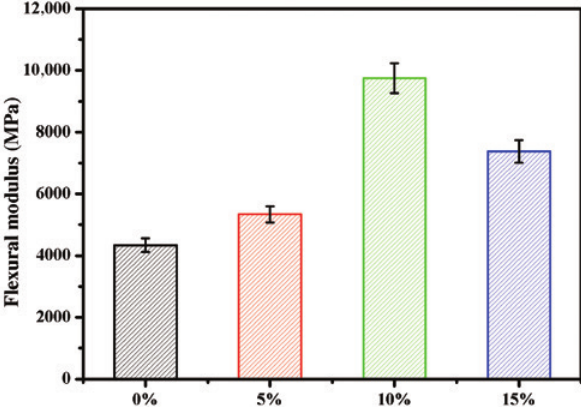
Figure 8: Flexure modulus of BAPh/PEN-OH polymers cured at 300 °